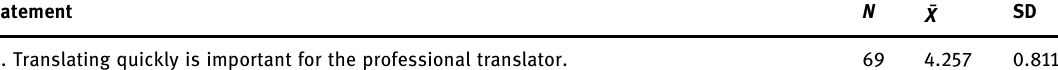
Table 4: Speed and professionalism Statement N X